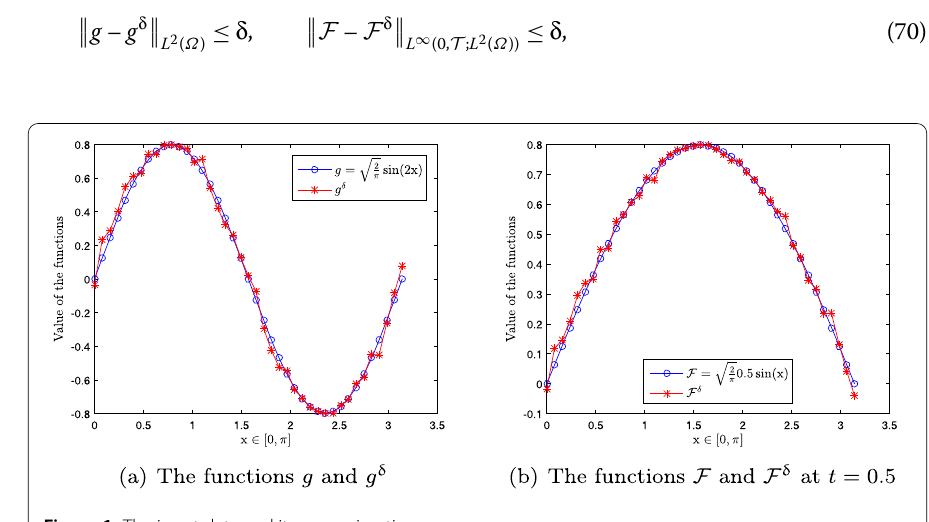
Figure 1 The input data and its